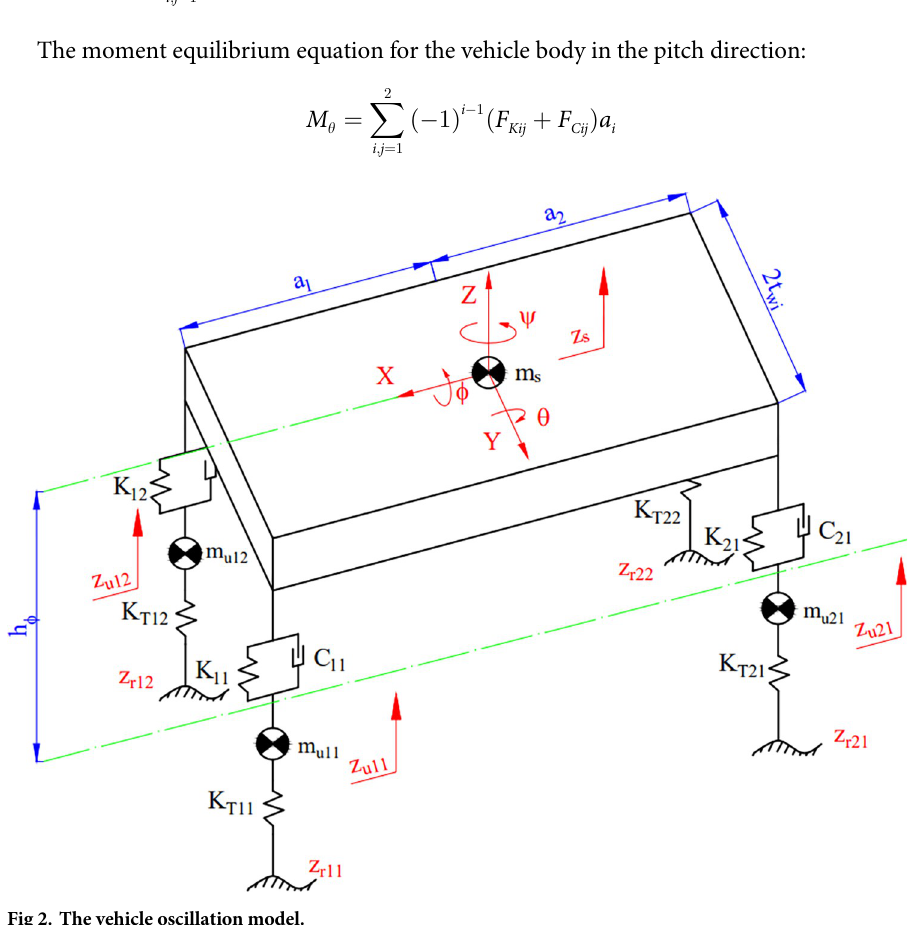
Fig 2. The vehicle oscillation